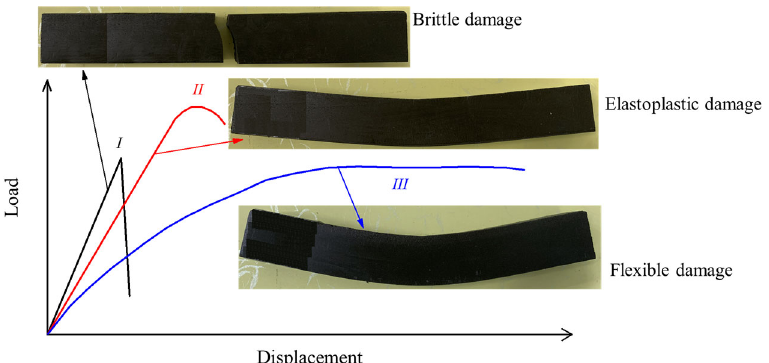
Figure 25. Three failure modes of load–displacement curves.